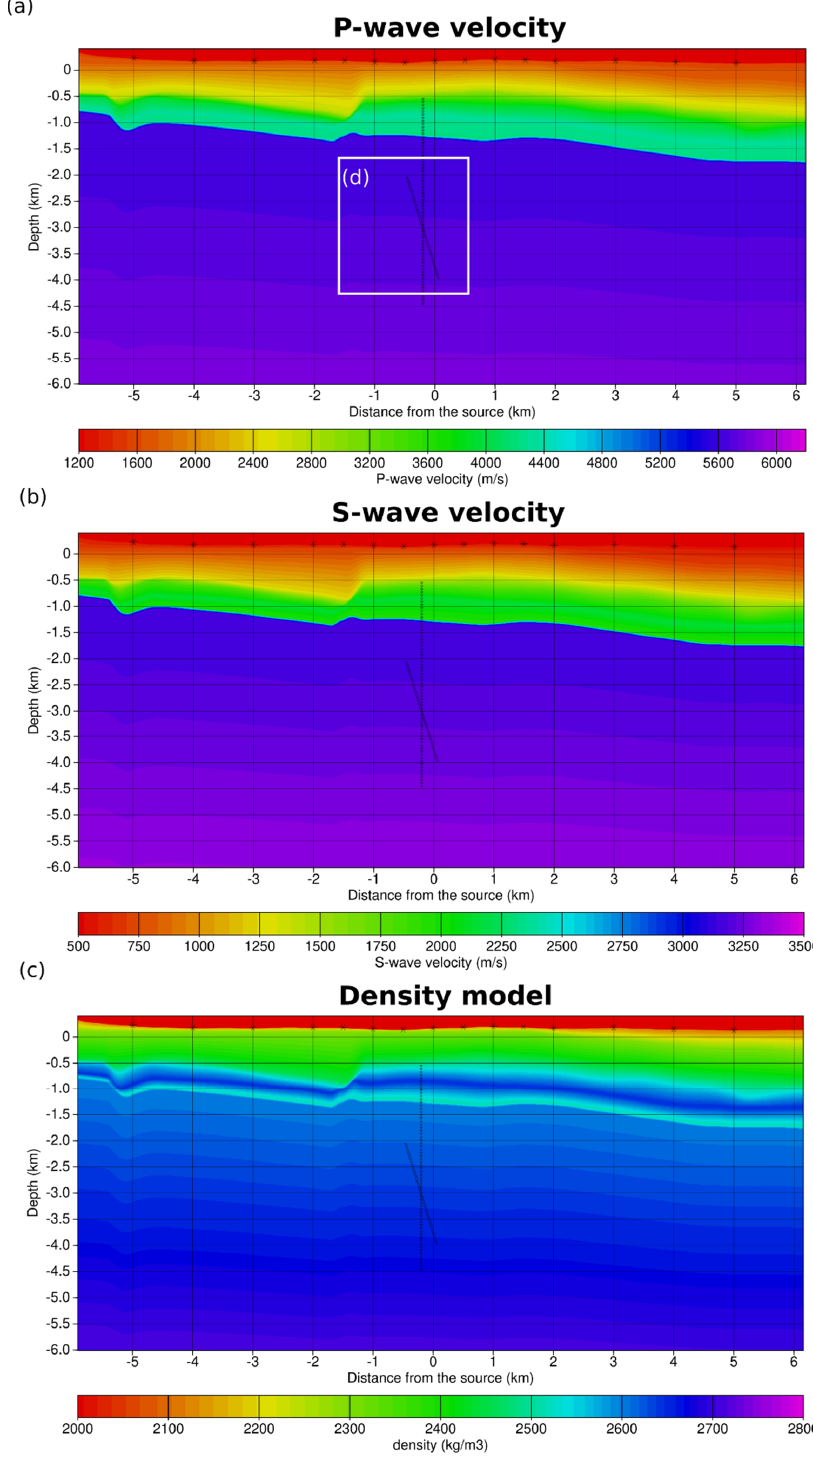
Figure 2. Physical models used to perform a sensitivity study of experiments. ( a , b ) the P-wave and S-wave velocity models, and ( c ) the density model. ( d ) shows the target area around the receivers where the results will be shown. The inverted triangles are the receivers located in the well and the stars are the source locations on the earth's surface. Note that the inter-shot is variable, 500 m around the well head to 1000 m far away the well head.